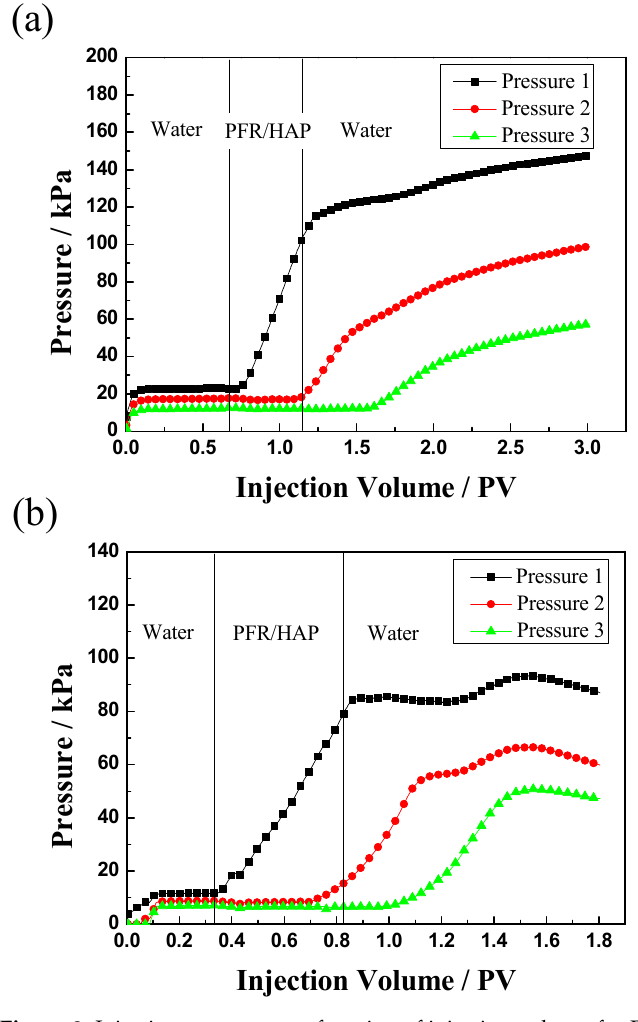
Figure 8. Injection pressure as a function of injection volume for PFR/HAP dispersion flood for sand packs (( a ): K: 380 mD, PFR:HAP 300:100 mg/L; ( b ): K:1000 mD, PFR:HAP 1200:400